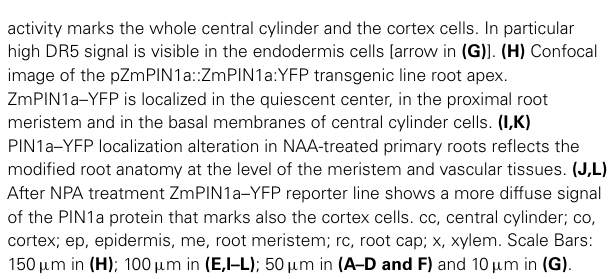
activity marks the whole central cylinder and the cortex cells. In particular high DR5 signal is visible in the endodermis cells [arrow in (G) ]. (H) Confocal image of the pZmPIN1a::ZmPIN1a:YFP transgenic line root apex. ZmPIN1a–YFP is localized in the quiescent center, in the proximal root meristem and in the basal membranes of central cylinder cells. (I,K) PIN1a–YFP localization alteration in NAA-treated primary roots reflects the modified root anatomy at the level of the meristem and vascular tissues. (J,L) After NPA treatment ZmPIN1a–YFP reporter line shows a more diffuse signal of the PIN1a protein that marks also the cortex cells. cc, central cylinder; co, cortex; ep, epidermis, me, root meristem; rc, root cap; x, xylem. Scale